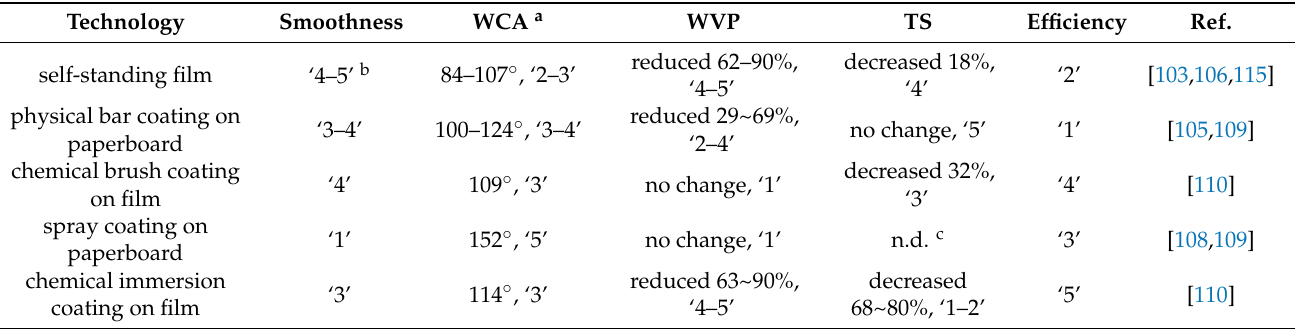
Figure 6. Strategies for cellulose ester-based packaging manufacture. Table 6. Influence of packaging manufacturing technologies on properties of cellulose ester-based packaging (DS = 0.2–2.8).